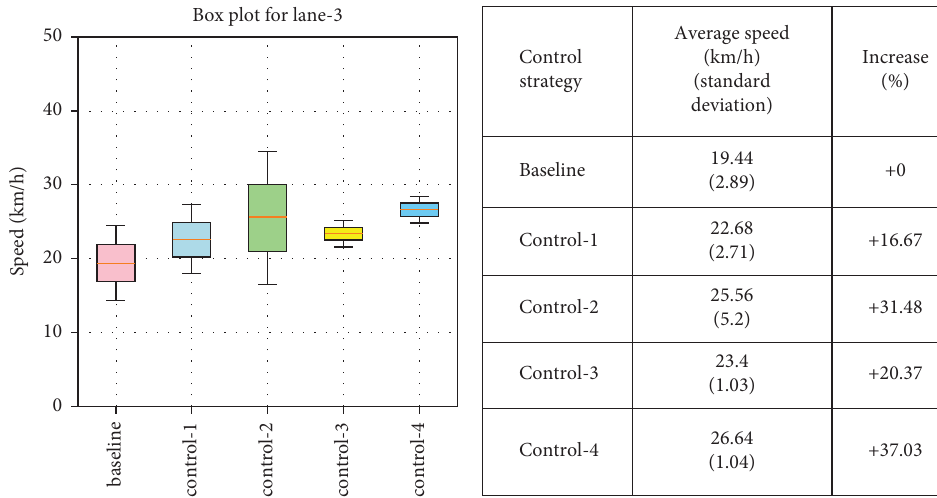
Figure 11: Vehicle speed distribution for diferent control strategies in lane-3.